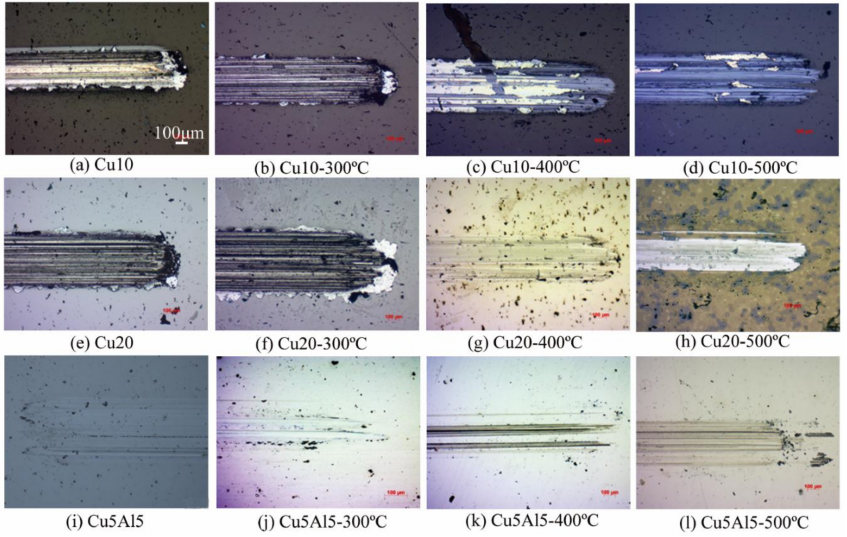
Figure 7. OM micrographs of MoS 2 -based composite coating wear tracks following heat